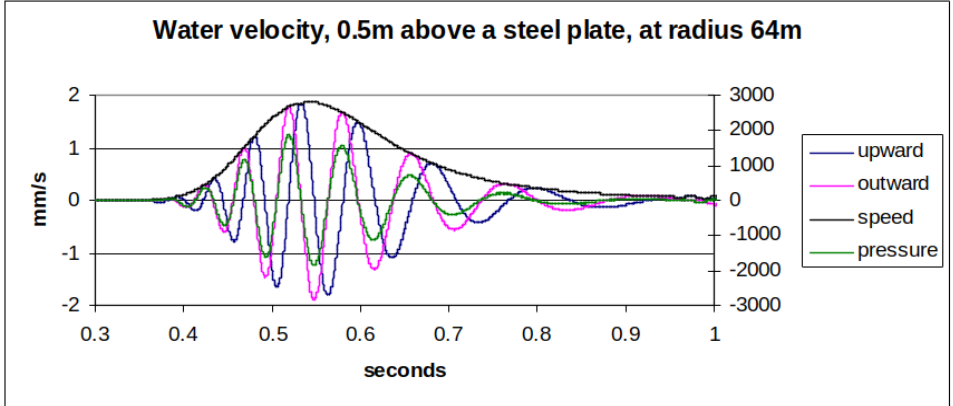
Figure 5. A water-particle response in a dispersive-tank model. The envelope is no longer sym- metrical with time, being stretched on its trailing edge by dispersion in the flexural waves of the tank baseplate.